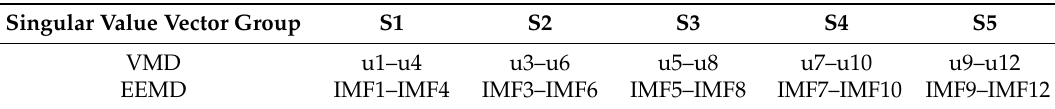
Figure 7. VMD results of gear with breakage: ( a ) modes; ( b ) frequency spectrums. Table 2. The partition of modes using variable mode decomposition (VMD) and intrinsic mode functions (IMFs) using ensemble empirical mode decomposition